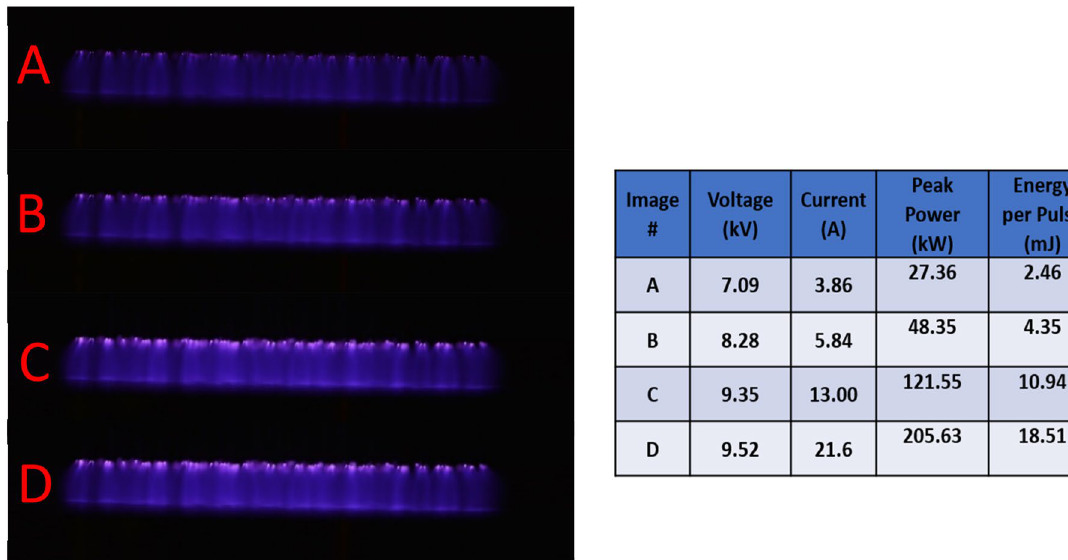
Figure 1. ( A – D ) Images of the large volume air plasma formation as a function of increasing energy per pulse at 2000 Hz. On the right, the table presents the corresponding applied voltage and discharge current, the peak power and the energy per pulse for each